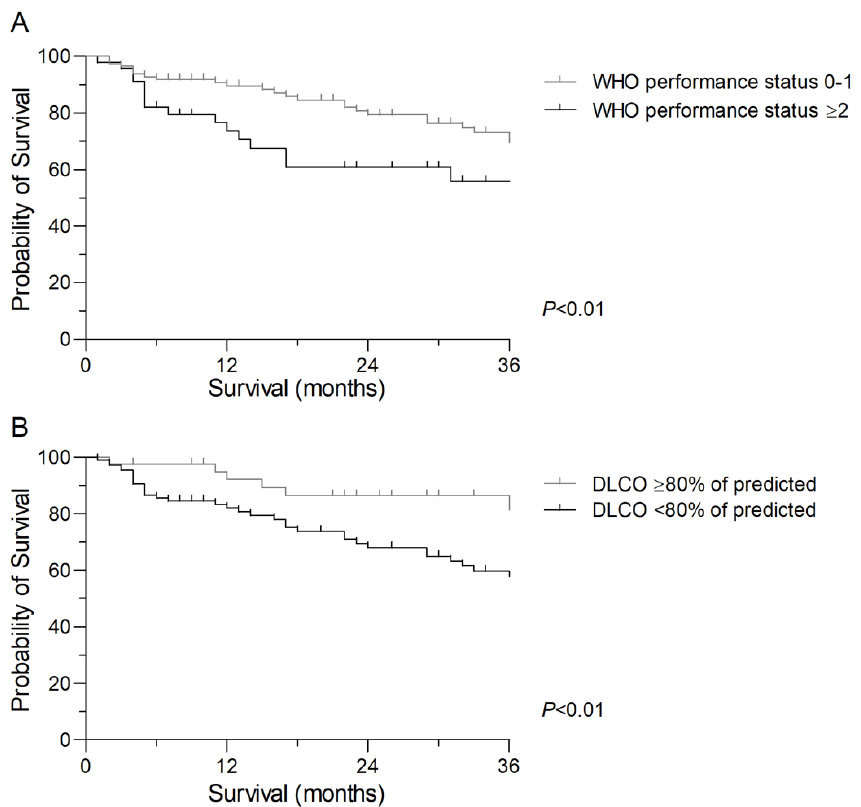
Figure 1. Kaplan–Meier survival curves for patients with non-small cell lung cancer who underwent surgery or stereotactic ablative radiotherapy. ( A ). Kaplan–Meier survival curve according to pretreatment World Health Organization (WHO) performance status (Log rank: p < 0.01). ( B ). Kaplan–Meier survival curve according to pretreatment diffusing capacity for carbon monoxide (DLCO) (Log rank: p <